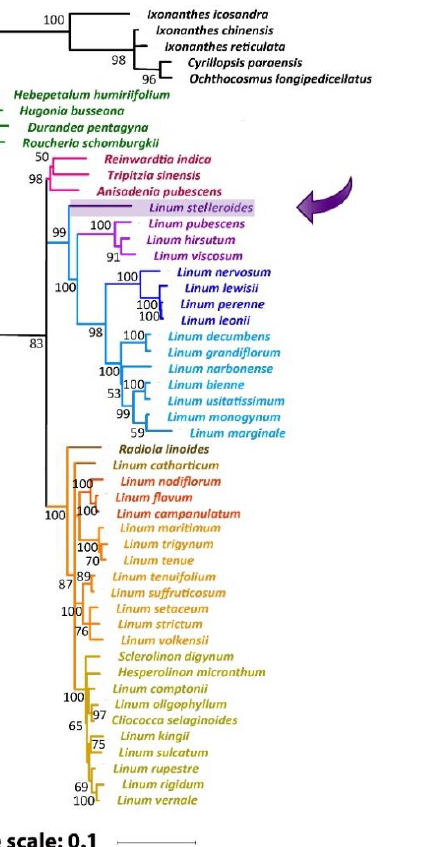
Figure 2. Maximum likelihood (ML) phylogeny of 11 loci of 45 Linaceae taxa and the selected outgroup of 5 Ixonanthaceae taxa. The values shown above or below branches are the node supports assessed by bootstrap values. The position of L. stelleroides is marked with an arrow.